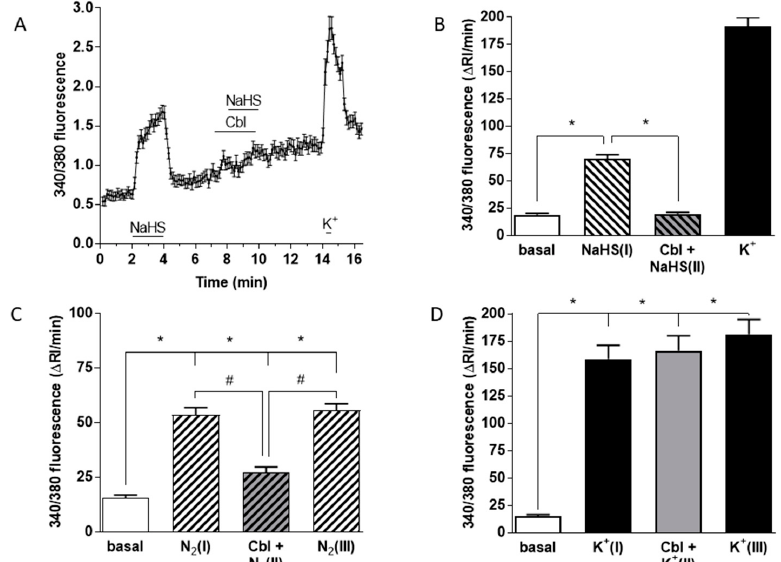
Figure 5. Effects of Cbl on the intracellular Ca 2+ responses elicited by 50 µM NaHS, hypoxia, and high external K + . [Ca 2+ ] i was assessed as the F340/F380 fluorescence emission ratio in